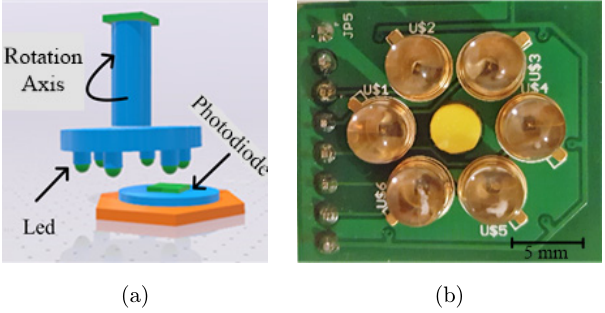
Fig. 5. Positioning of NIR LEDs (a) Schematic view. (b) Actual view of LED